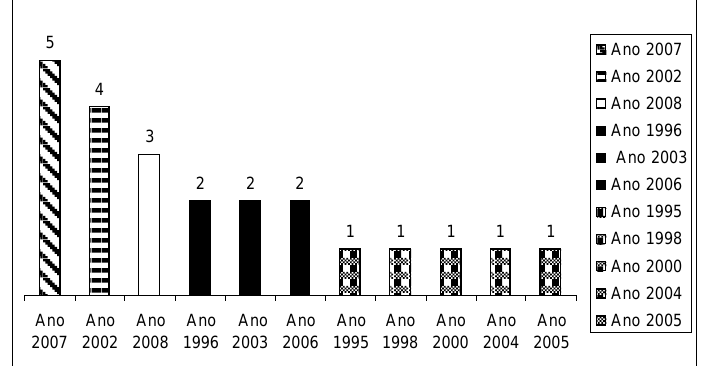
Figura 6. Distribuição dos grupos de pesquisa por ano de